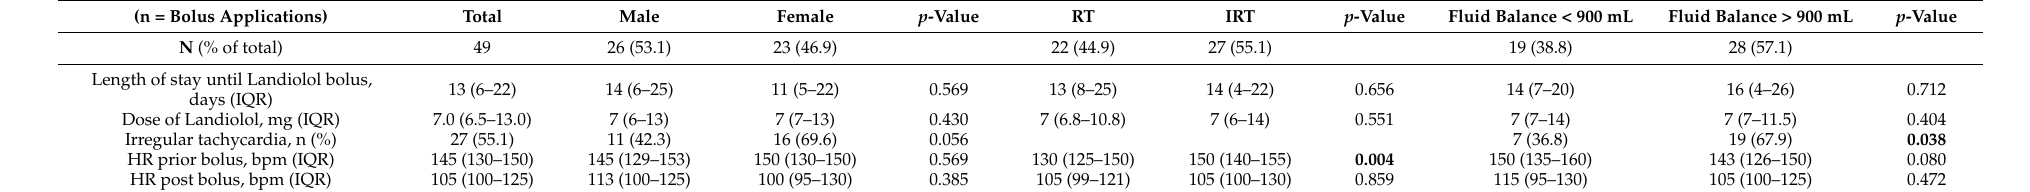
Table 2. Details and circumstances of Landiolol bolus application, overall and stratified in terms of gender, RT and IRT, and fluid balance. The fluid balance accounts for the overall balance right before push-dose Landiolol application. “IRT” and “RT” concerns the heart rhythm before bolus Landiolol application. Categorical data are presented as counts and percentages, and continuous data as medians and interquartile ranges (IQRs). Categorical data were analyzed using a test for linear association (Mantel–Haenszel chi-square test) or Fisher’s exact test, and continuous data using Kruskal–Wallis test for testing within the subgroups. Wilcoxon rank test was used for analyzing blood pressure and heart rate changes. RT = regular tachycardia; IRT = irregular tachycardia; NIV = non-invasive ventilation; NHF = nasal